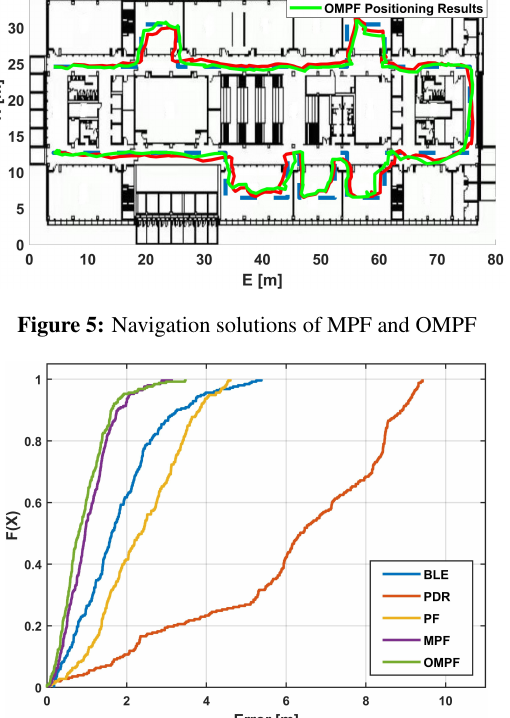
Figure 4: Positioning results of BLE, PDR, PF, and MPF for the first trajectory with a total length of approximately 230 m: ( a ) the positioning performance of BLE and PDR and ( b ) the positioning performance of PF and MPF.